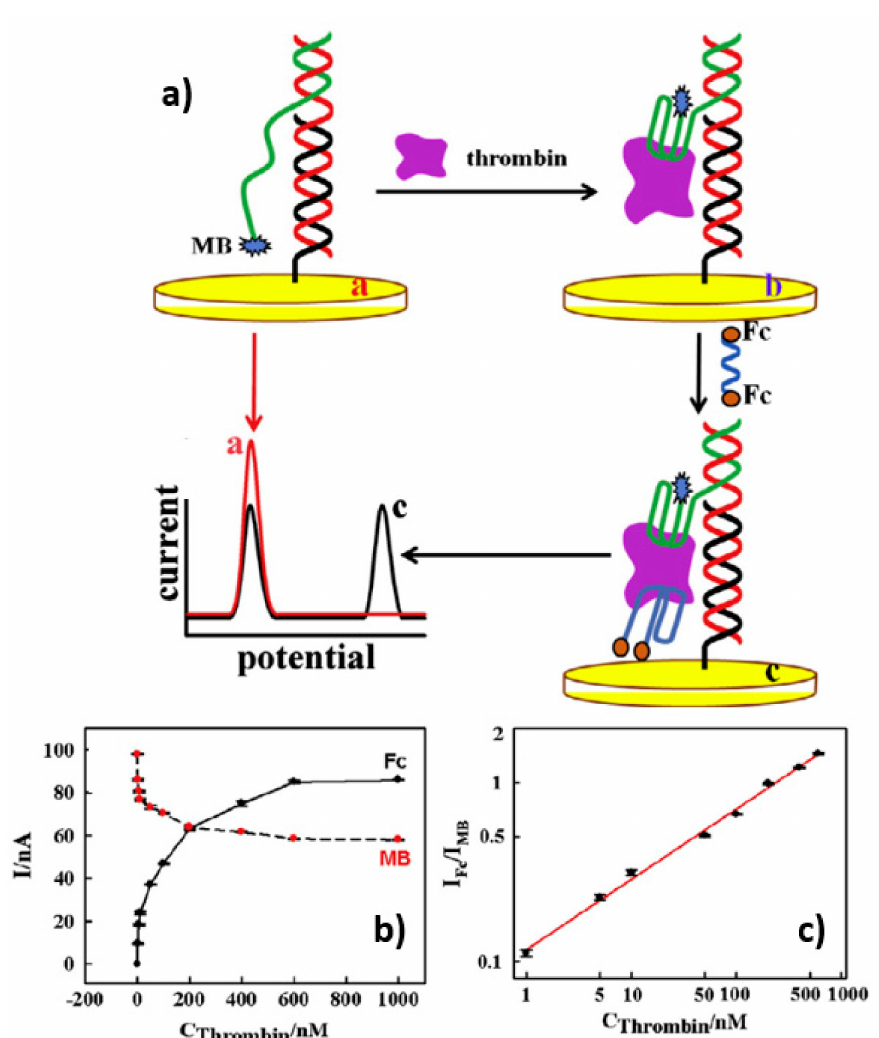
Figure 5. ( a ) The schematic illustration of the ratiometric electrochemical aptasensor for thrombin detection; ( b ) the relationship between the SWV peak current of MB and Fc and the thrombin concentration (linear scale); ( c ) the dependence of the peak current ratio I Fc /I MB on thrombin concentration (logarithmic scale). Reprinted with permission from [123]. Copyright 2014